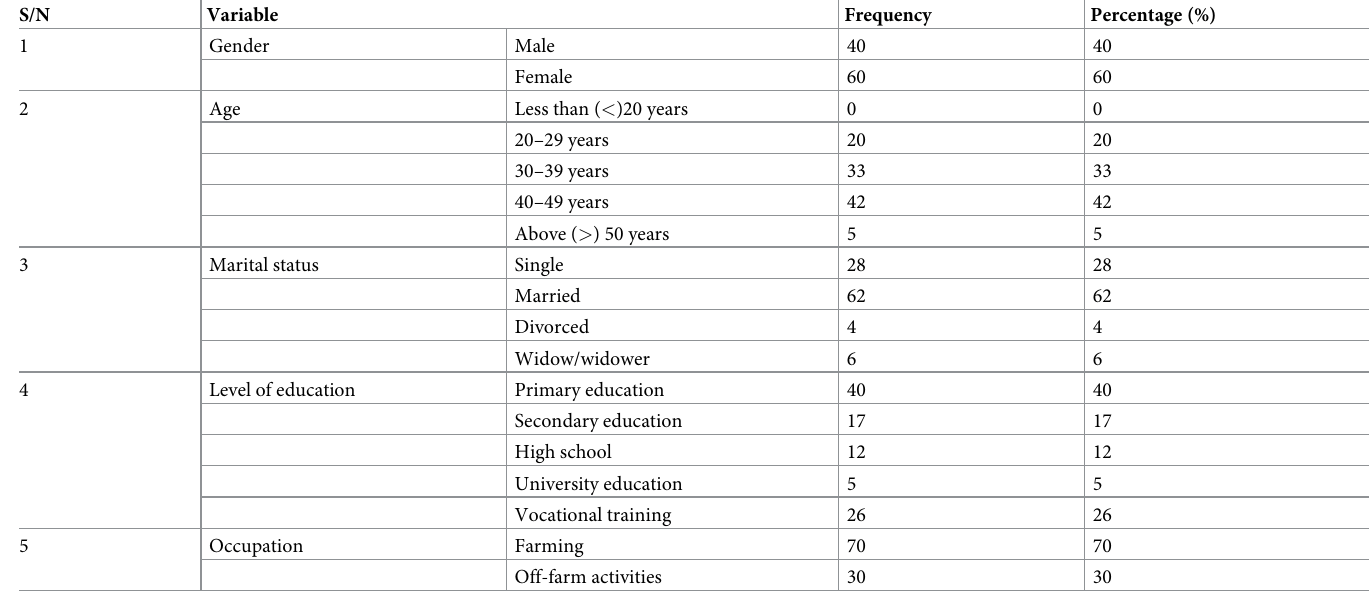
Table 2. Personal information of respondents involved in informal seed system of okra.